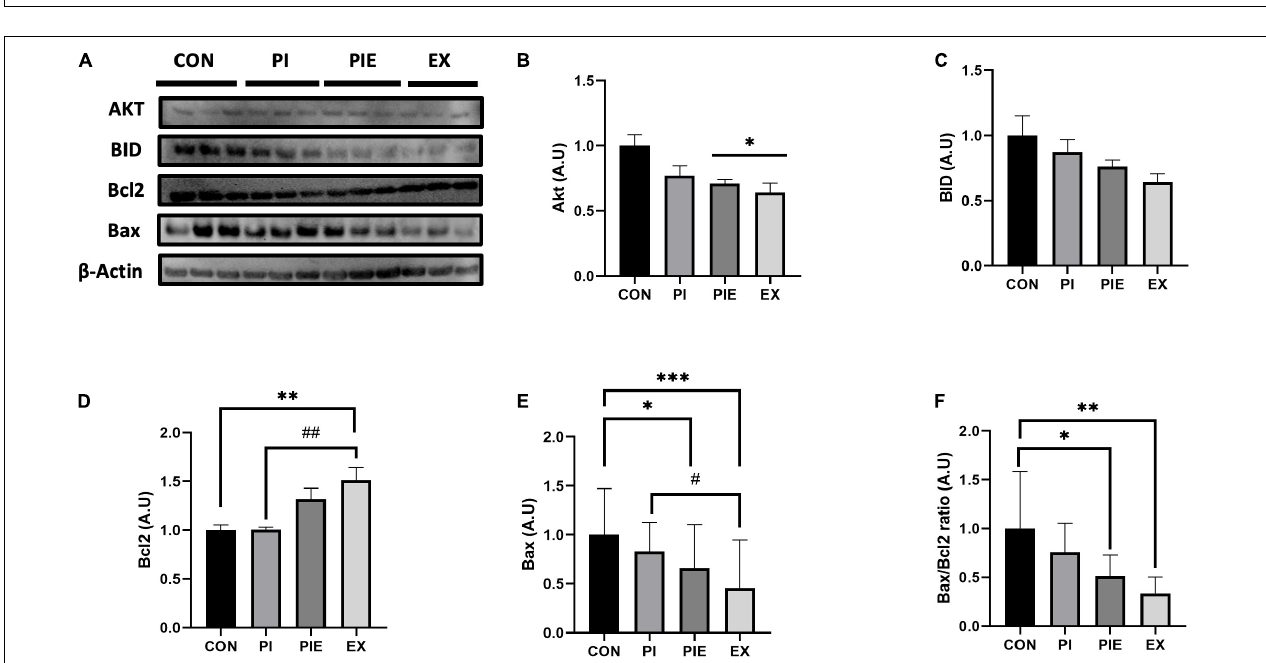
FIGURE 10 | PM exposure increased the expression of autophagy-related markers in the lung. (A) Representative western blot images of ATG13, ATG101, LC3 I, II, and Parkin 2. Western blot analysis was performed to access the effect of PM exposure on ATG13 (B) , ATG101 (C) , Parkin 2 (D) , LC3 I (E) , LC3 II (F) , and LC3 II/I ratio (G) . Values are the means ± SEM ( n = 6). & P < 0.05 vs. PIE.